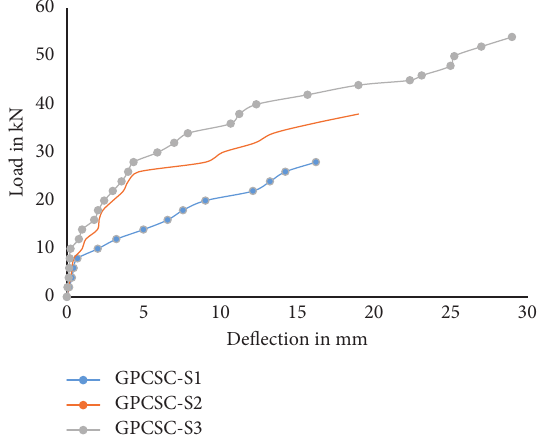
Figure 11: Load-deflection behaviour of GPCSC (SRB).